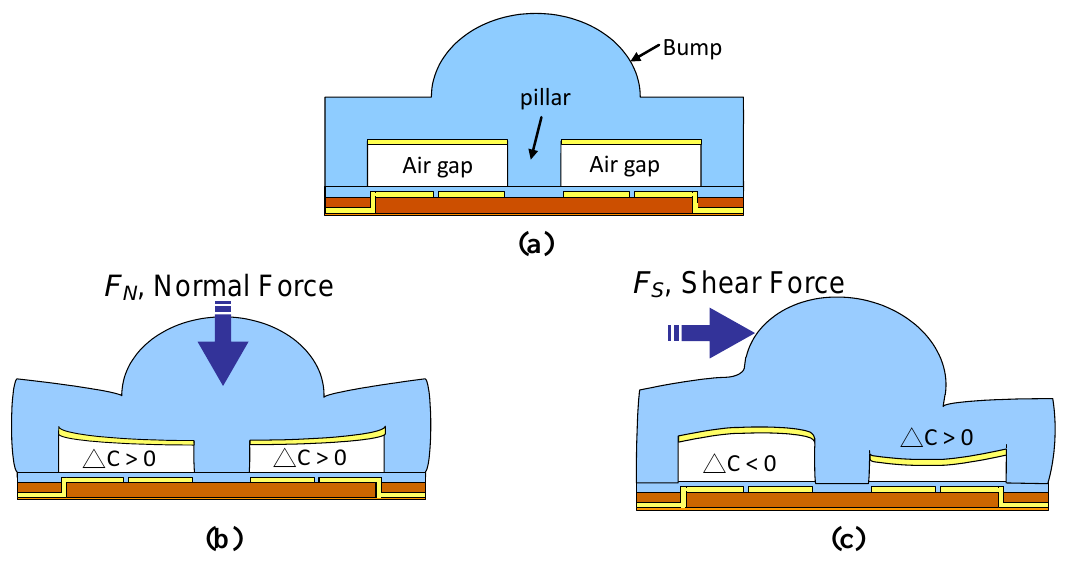
Figure 3. Schematic of a shear stress sensing element (a) without applied forces, (b) with a normal force, (c) with a shear